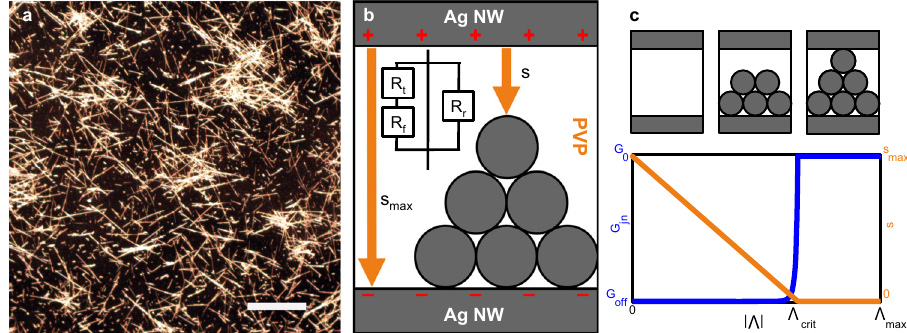
Fig. 1 Ag-PVP nanowire networks with memristive junctions. a Optical microscope image of a self-assembled Ag-PVP NWN (scalebar = 100 μ m). b Biased nanowire-nanowire junctions promote Ag + migration and redox-induced Ag fi lament formation through the electrically insulating, ionically conducting PVP layer. Filament gap distance s varies from s parallel with constant fi lamentary resistance ( R f ¼ G (cid:2) 1 function of state variable Λ ( t ). As ∣ Λ ∣ increases, the junction transitions from high resistance to tunnelling and then ballistic